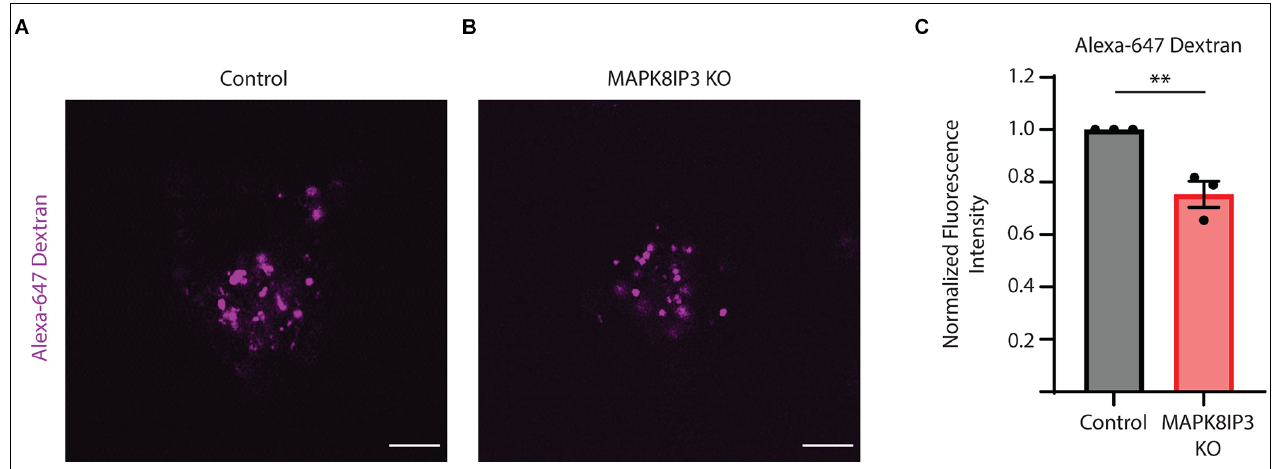
FIGURE 3 | Dextran uptake is reduced in MAPK8IP3 KO i 3 Neurons. (A,B) Representative images of Control and MAPK8IP3 KO i 3 Neurons at DIV15 after overnight Alexa-647 Dextran incubation and 1 h washout. Scale bar: 5 µ m. (C) Quantification of Alexa-647 Dextran fluorescence intensity normalized to Control. Mean ± SEM from three independent experiments (** P < 0.01; unpaired t -test). Control = 60 cells; MAPK8IP3 KO = 74